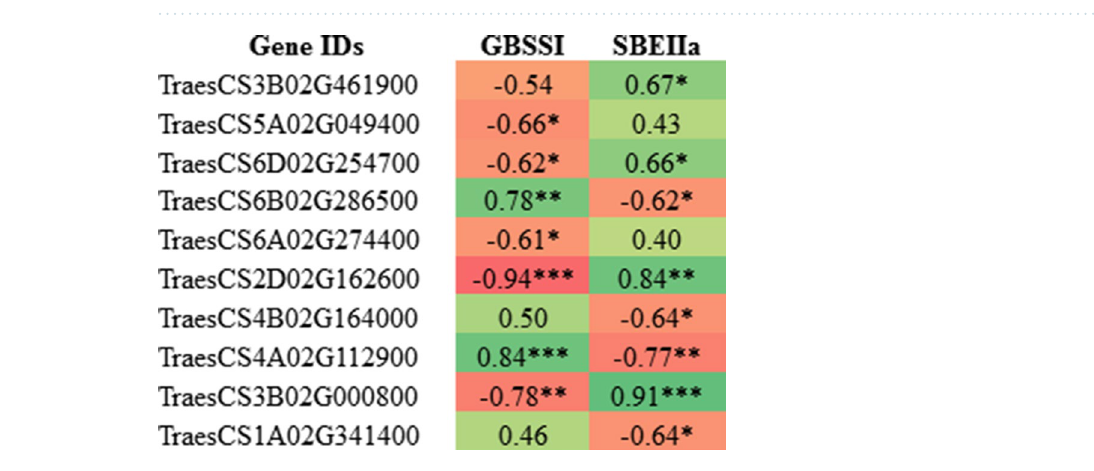
Figure 8. Bar graphs showing the differential gene expression of 11 candidate RING protein genes along with GBSSI and SBEIIa using qRT-PCR for amylose biosynthesis at ( A ) 7 DAA, ( B ) 14 DAA, ( C ) 21 DAA and ( D ) 28 DAA in ‘TAC 75’ vs. ‘C 306’ and ‘TAC 6’ vs. ‘C 306’. ‘TAC 75’ and ‘TAC 6’ are high and low amylose mutant lines derived from parent variety ‘C 306’ with amylose percent ~ 65%, ~ 7%, ~ 26%, respectively. The results were obtained using three technical and three biological replicates and are expressed as mean ± SD.